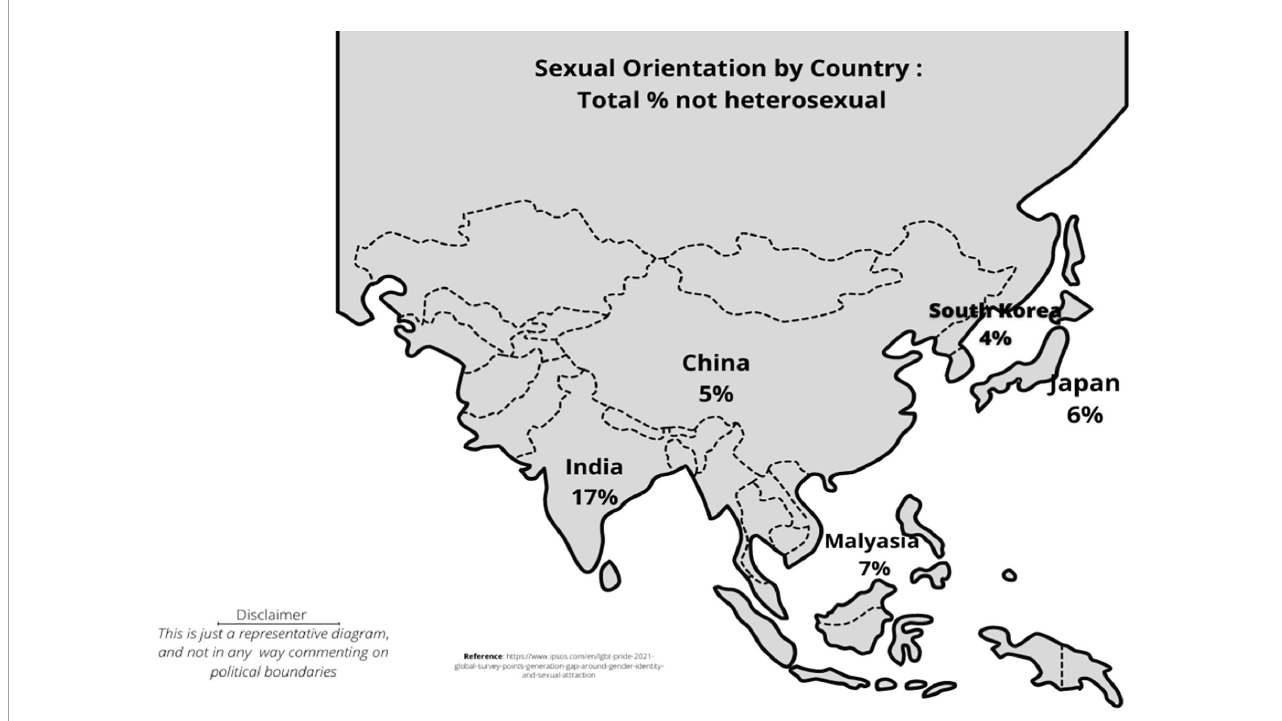
FIGURE1 The percentage of individuals who identify as non-heterosexual in the Indian subcontinent according to LGBT + Pride 2021 Global Survey